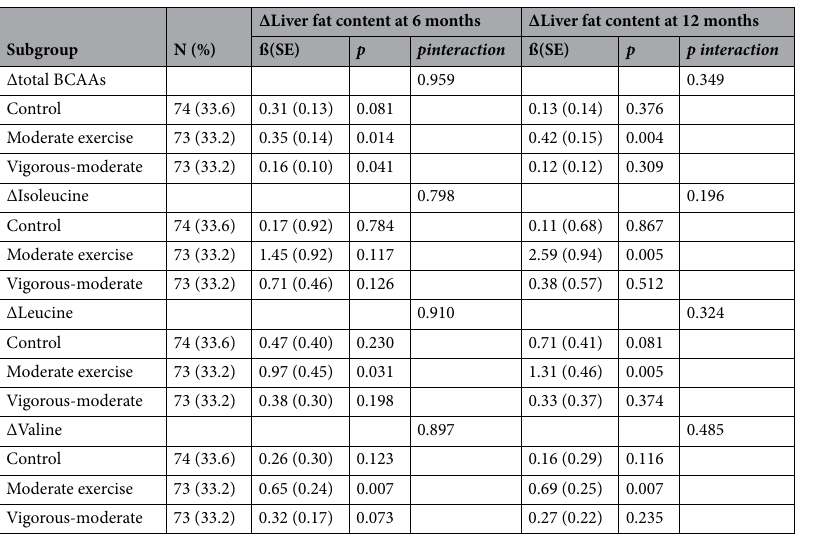
Table 8. Subgroup analyses of associations of change in BCAAs levels with the improvement in liver fat content. ß (SE) represented changes of the outcomes per change in the circulating metabolite levels during the exercise intervention. Data after adjustment for age, sex, total energy intake, protein intake, HOMA-IR, BMI, liver fat content at the baseline, value for the respective metabolites (total BCAAs, Isoleucine, Leucine,Valine) at the baseline, and changes in HOMA-IR and BMI from baseline to 6 months. Abbreviations: HOMA-IR homeostatic model assessment of insulin resistance; BMI body mass